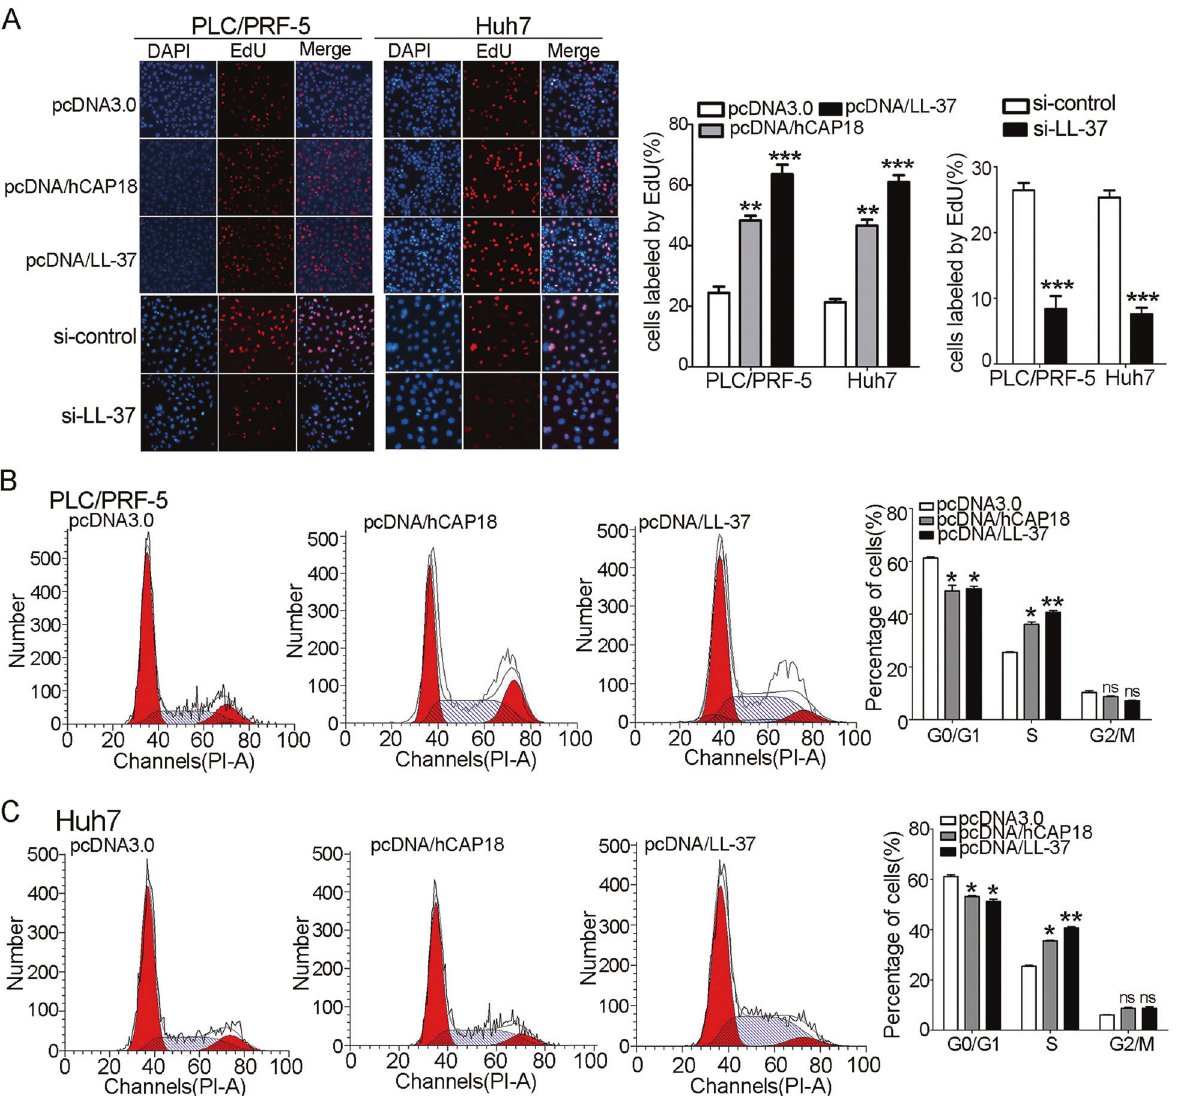
Fig. 3 hCAP18/LL-37 expression promotes cell proliferation and cell cycle progression in HCC cells. A EdU proliferation assay was conducted in PLC/PRF-5 and Huh7 cells after transfection with pcDNA/hCAP18, pcDNA/LL-37, or si-LL-37, respectively. EdU-positive cells were counted for statistical analysis. Cell cycle analysis was performed in PLC/PRF-5 ( B ) and Huh7 ( C ) cells by PI staining and fl ow cytometry detection. The cells transfected with pcDNA3.0 were used as a control. Data represent the mean ± SEM for 4 – 6 independent experiments. * p < 0.05, ** p < 0.01, *** p < 0.001, and ns (no signi fi